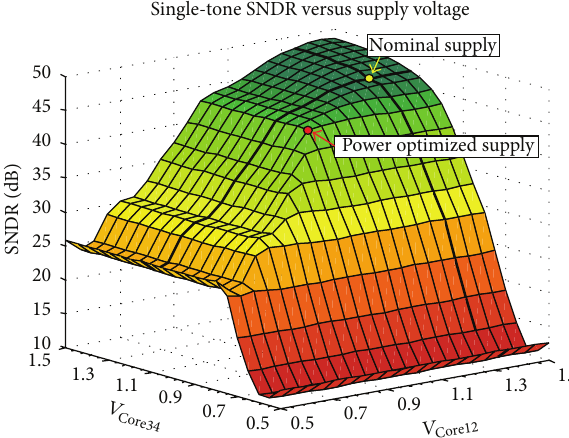
Figure 23: Measured SNDR as a function of CRAFT core supply voltages.